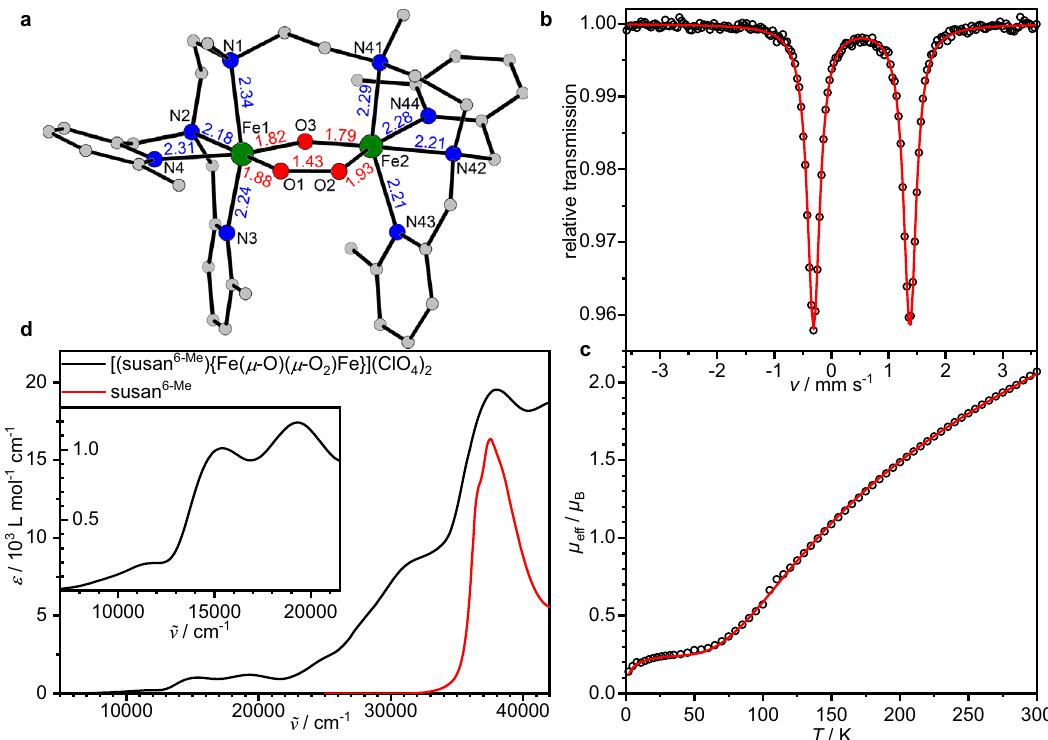
Fig. 2 Characterization of [(susan 6-Me ){Fe III ( μ -O)( μ -O 2 )Fe III }](ClO 4 ) 2 . a Molecular structure of [(susan 6-Me ){Fe III ( μ -O)( μ -O 2 )Fe III }] 2 + in single-crystals of [(susan 6-Me ){Fe III ( μ -O)( μ -O 2 )Fe III }](ClO 4 ) 2 • 0.85CH 3 CN • 0.7H 2 O. Hydrogen atoms have been omitted for clarity. b 57 Fe Mössbauer spectrum of [(susan 6-Me ){Fe III ( μ -O)( μ -O 2 )Fe III }](ClO 4 ) 2 at 80 K. The solid line is a simulation with δ = 0.53 mm s − 1 , | Δ E Q | = 1.69 mm s − 1 , and Γ = 0.26 mm s − 1 . c Temperature-dependence of the effective magnetic moment, μ eff , of [(susan 6-Me ){Fe III ( μ -O)( μ -O 2 )Fe III }](ClO 4 ) 2 . The solid line is a simulation to the spin- Hamiltonian (1) in the Supplementary Information with J = − 155 cm − 1 , g i = 2.05, 0.2% p.i. ( S = 5/2) of same molecular mass and Θ w,pi = − 8 K. d UV-Vis-